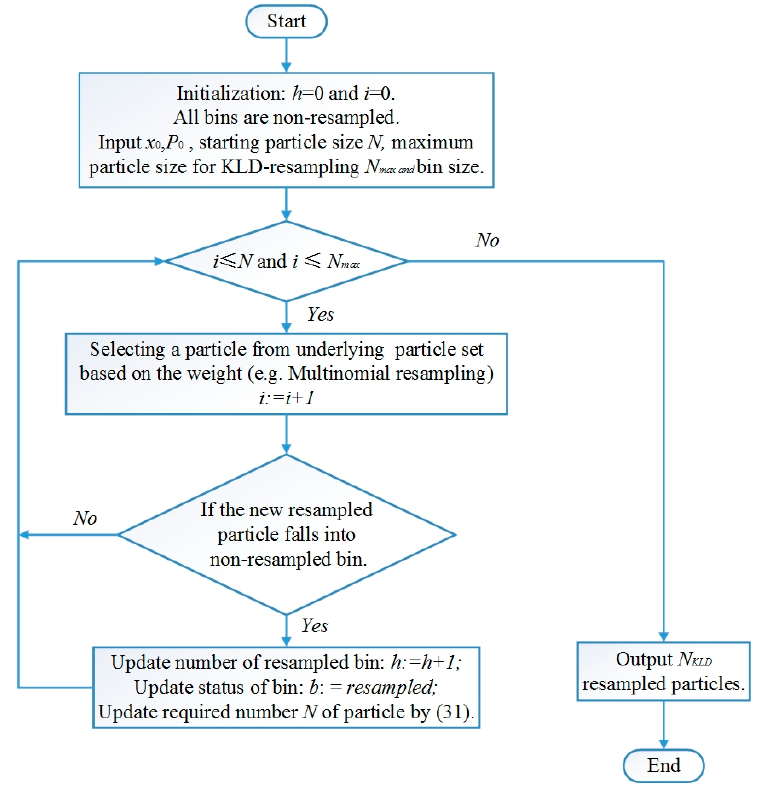
Figure 2. Procedure of Kullback-Leibler Divergence (KLD)-resampling.